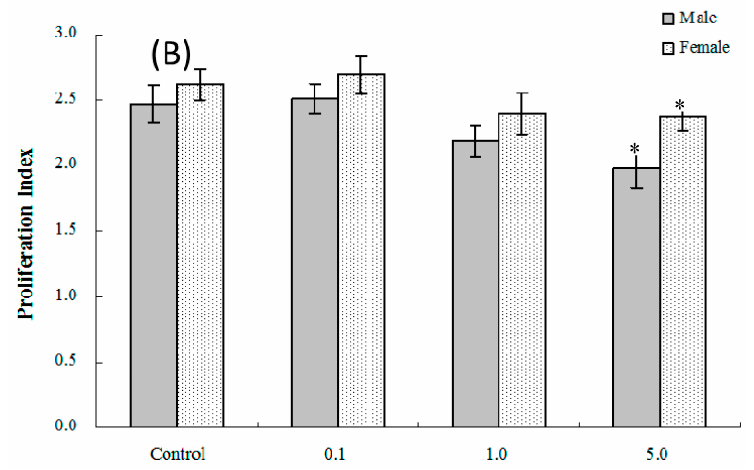
Figure 2. Ex vivo splenic lymphocyte proliferation among splenocytes isolated from in C57BL/6 pups exposed in utero to PFOS during GD 1–17. ( A ) T and ( B ) B cell responses. Splenocytes from four-week-old hosts were isolated and then cultured (5 × 10 6 /well) with or without 10 μ g/mL concanavalin A (ConA) or LPS for 48 h, before proliferation was measured using MTT. A value of 1.0 for not significantly different between groups. Data shown are the mean ± SEM. * Value significantly